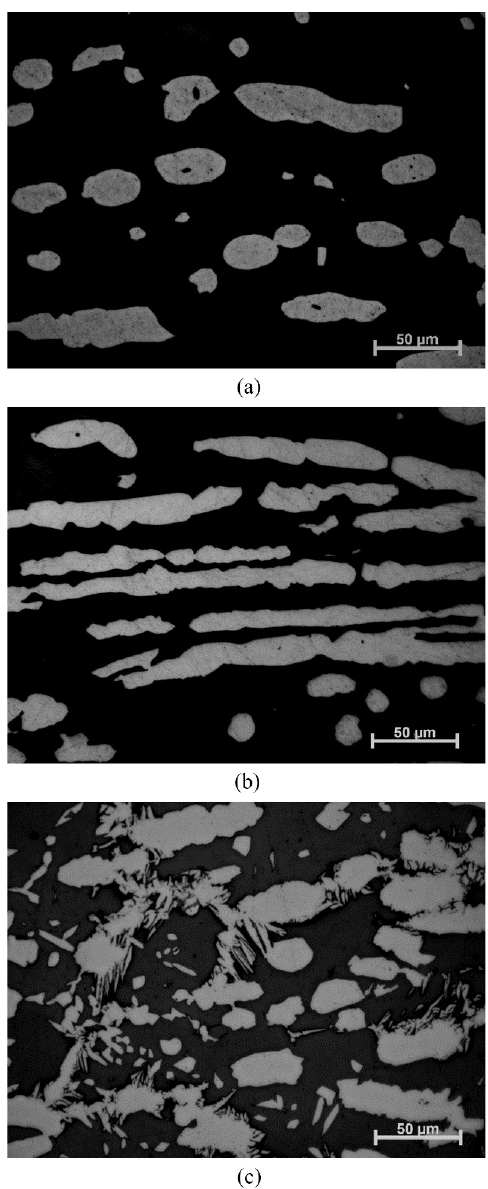
Figure 1. Optical Micrographs of 2205 DSS solution-treated and cooled (a) rapidly, (b) moderately and (c)